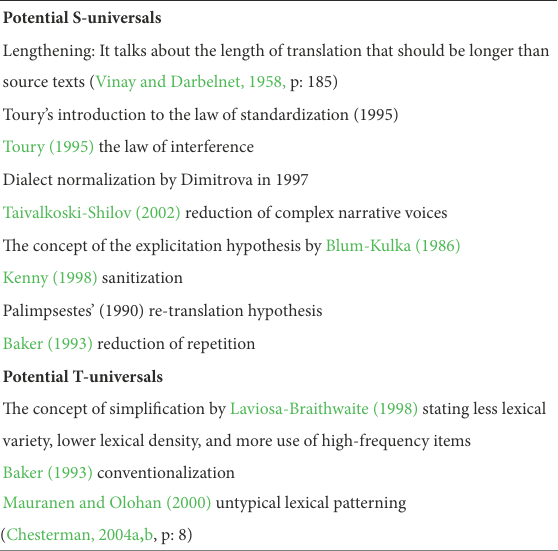
TABLE 1 Potential S-universals and T-universals. Based on data from Chesterman (2004a,b, p: 8). Potential